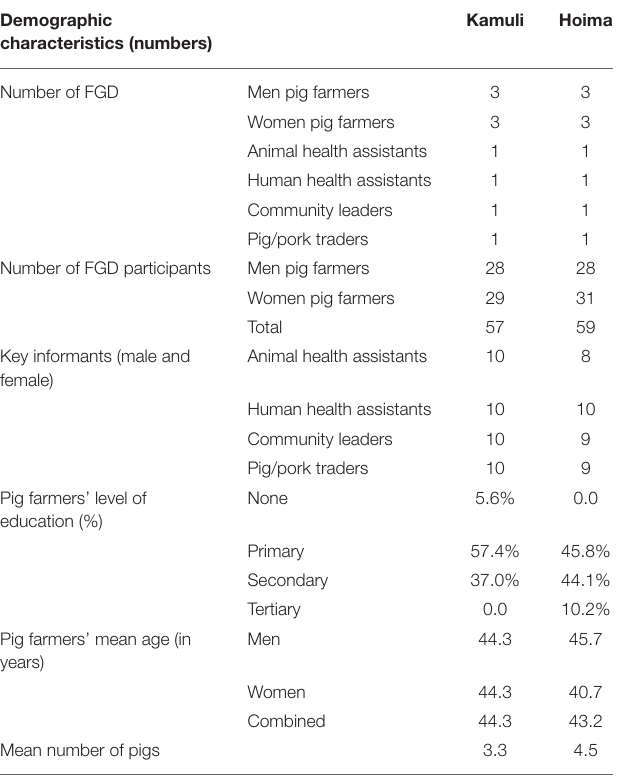
TABLE 2 | Demographic characteristics of the study participant categories. Demographic characteristics